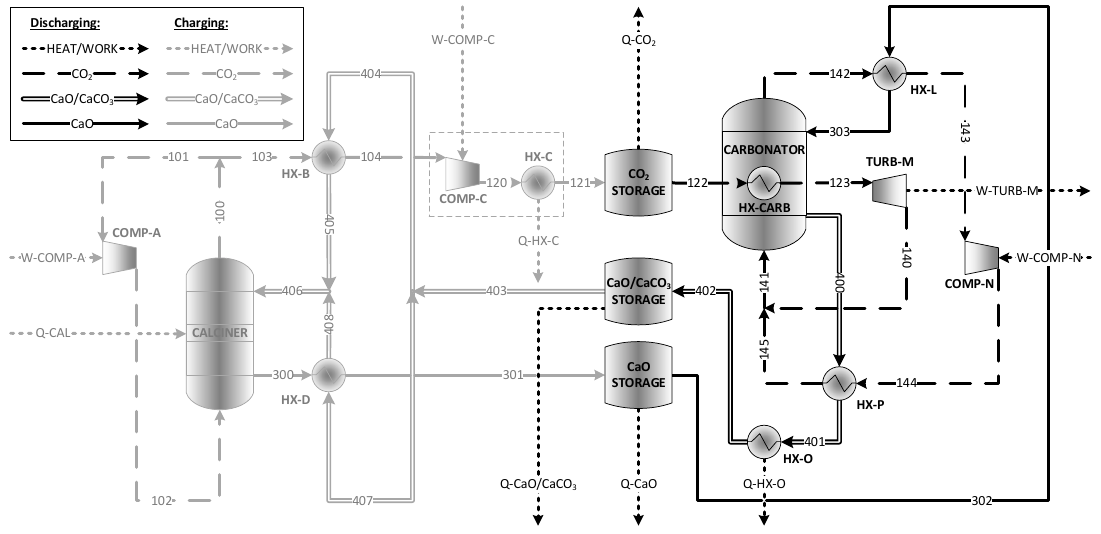
Figure 3. Process flow diagram for Configuration 2; Cold CaO storage and cold CaO/CaCO 3 storage.